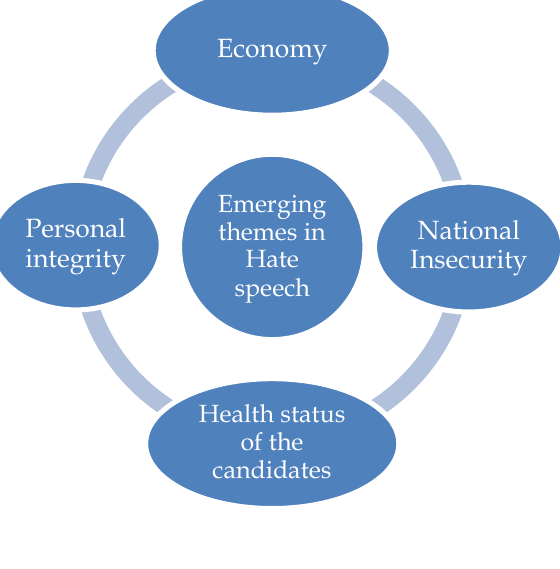
Figure 1: Emerging themes from hate speech contents. Source: Compiled by the